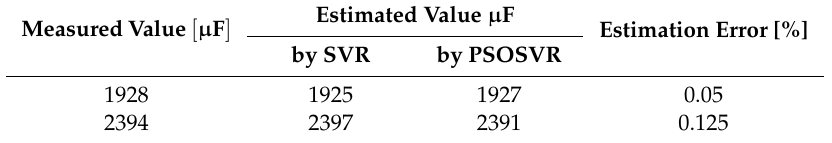
Table 2. Capacitance estimation error.